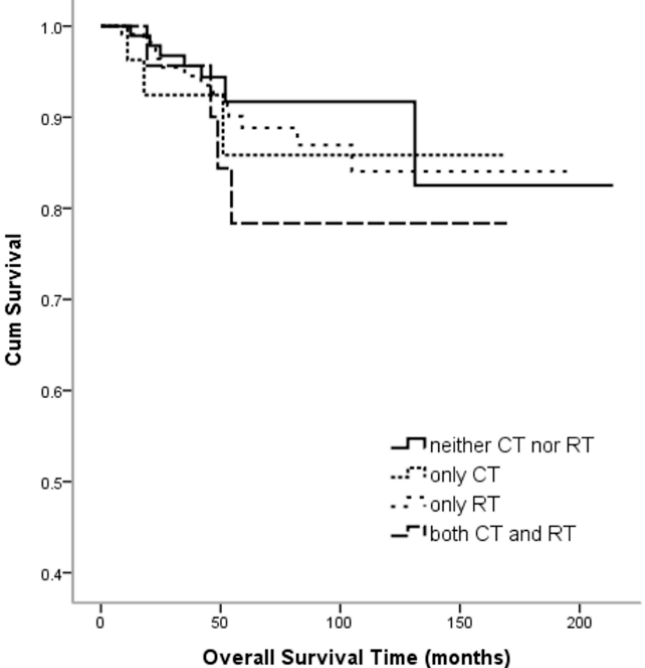
Figure 3. Kaplan-Meier survival estimates according to postoperative adjuvant therapies (log-rank, p = 0.621). CT: chemotherapy; RT: radiotherapy.